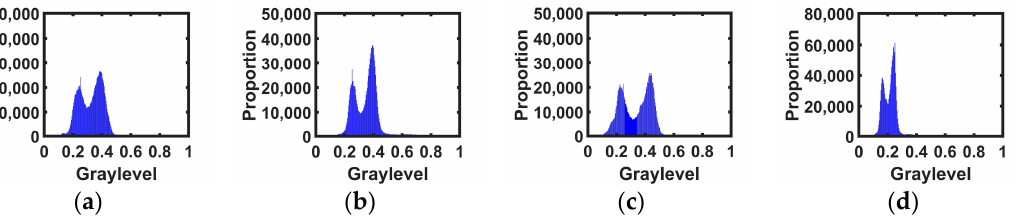
Figure 5. Original multispectral images’ histogram of the soybean canopy: ( a ) GRE histogram, ( b ) NIR histogram, ( c ) RED histogram and ( d ) REG histogram. Figure 5 showed that, in the original multispectral image of the soybean, the gray fre- quency distribution of green, NIR, red and red-edge channel was 0.1098~0.5255, 0.1176~0.8431, 0.1020~0.5686 and 0.0980~0.4667, reaching the peak at 0.3843, 0.3961, 0.4314 and